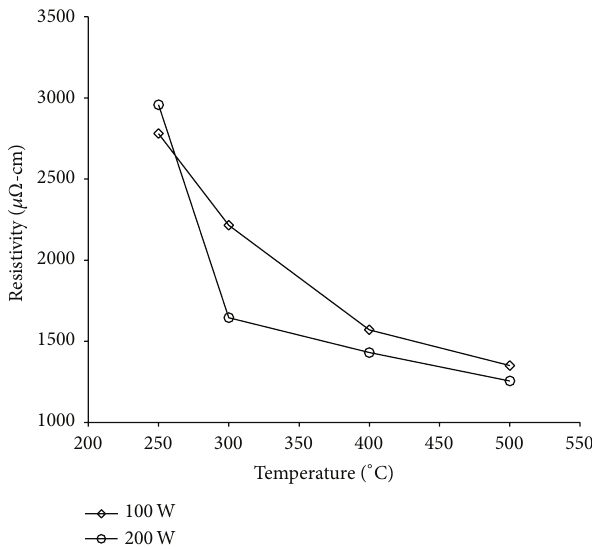
Figure 6: Room temperature resistivity of Ni-Cr-Si-Al-Ta films with different sputtering powers and annealing temperatures.